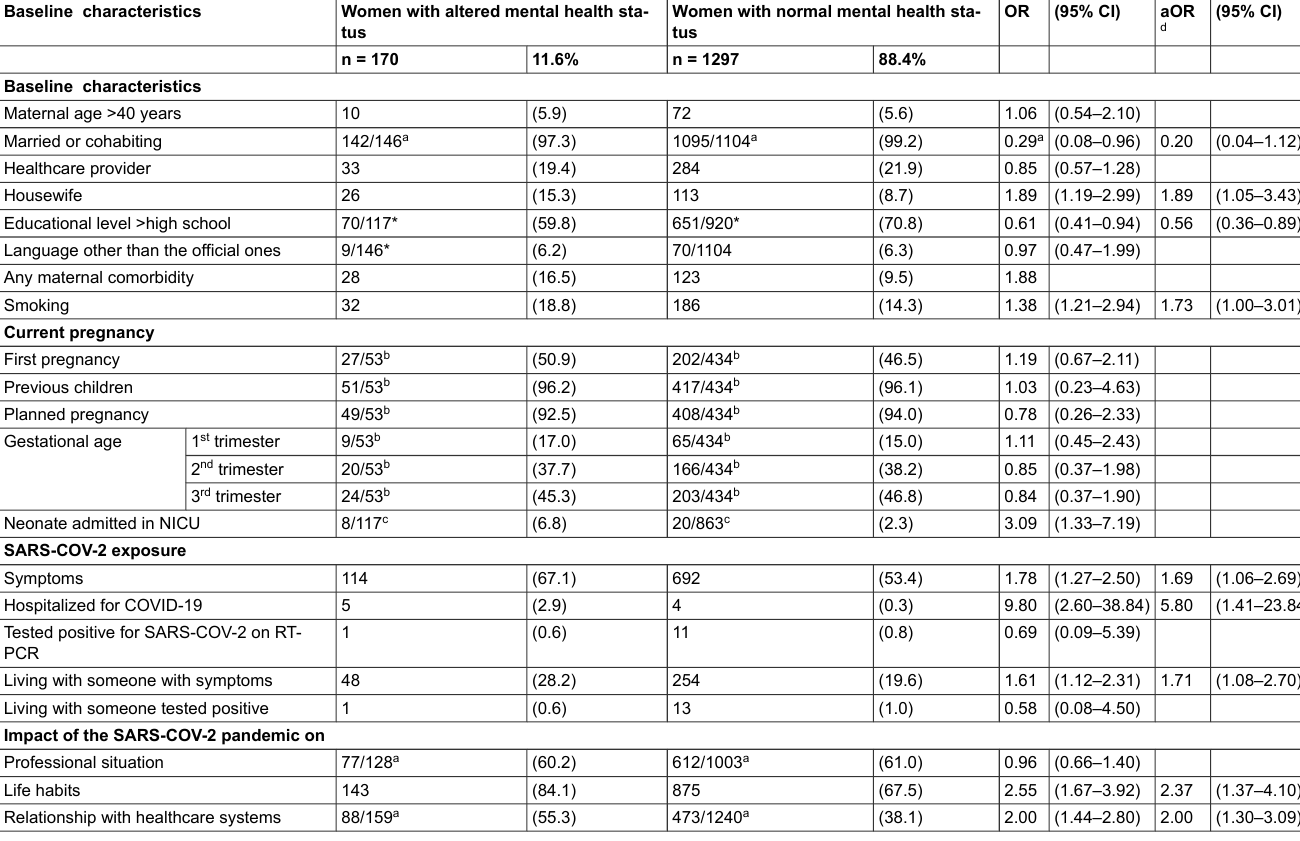
aOR: adjusted odds ratio; CI: confidence interval; OR: odds ratio; RT-PCR: reverse transcription polymerase chain reaction a Multiple imputations were performed on missing values, for variables with a denominator different from the overall denominator b Tested only in pregnant women